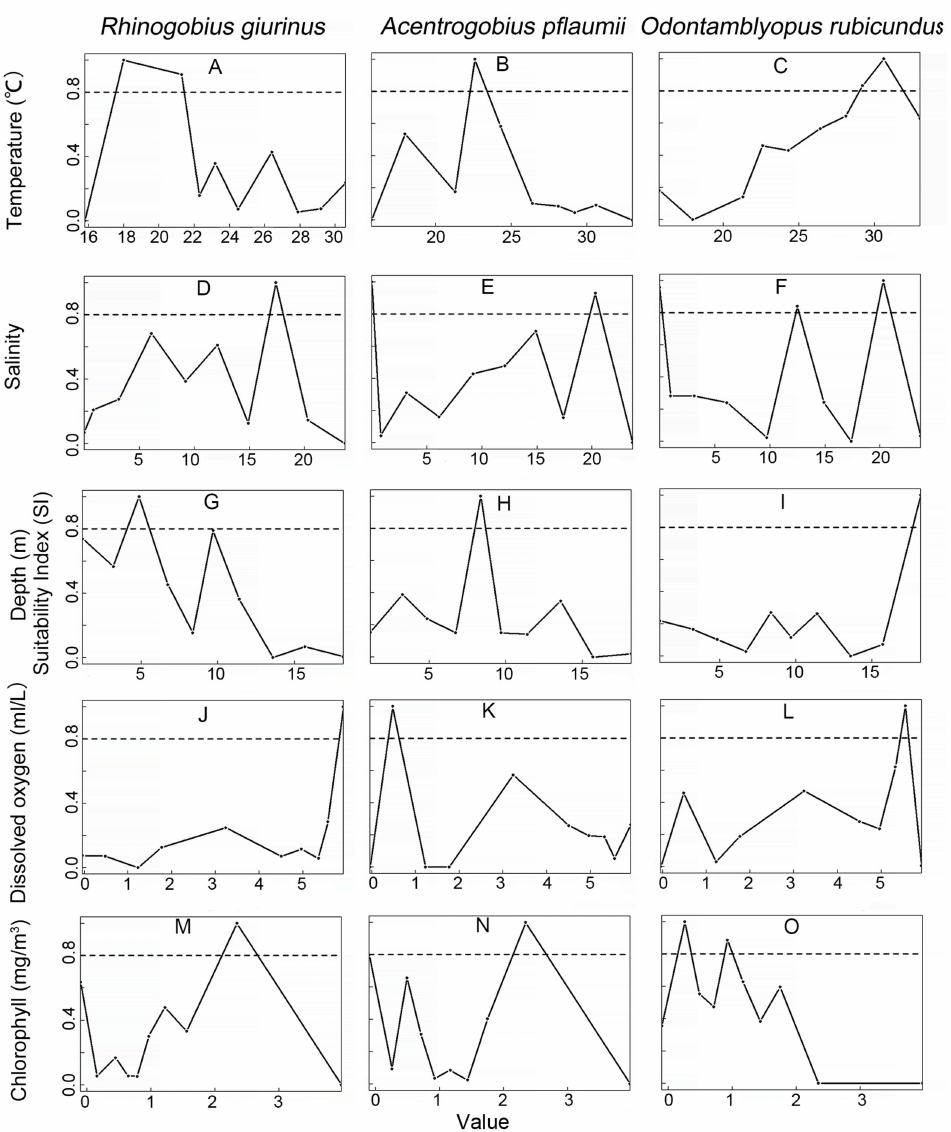
Figure 4. Suitability index curve (SIC) of three gobies with respect to environmental factors in the Yangtze Estuary (the inflection point of the line is the outer envelope point of the suitability index (SI); ( A ) SIC of temperature for R. giurinus ; ( B ) SIC of temperature for A. pflaumii ; ( C ) SIC of temperature for O. rubicundus ; ( D ) SIC of salinity for R. giurinus ; ( E ) SIC of salinity for A. pflaumii ; ( F ) SIC of salinity for O. rubicundus ; ( G ) SIC of depth for R. giurinus ; ( H ) SIC of depth for A. pflaumii ; ( I ) SIC of depth for O. rubicundus ; ( J ) SIC of dissolved oxygen for R. giurinus ; ( K ) SIC of dissolved oxygen for A. pflaumii ; ( L ) SIC of dissolved oxygen for O. rubicundus ; ( M ) SIC of chlorophyll for R. giurinus ; ( N ) SIC of chlorophyll for A. pflaumii ; ( O ) SIC of chlorophyll for O. rubicundus